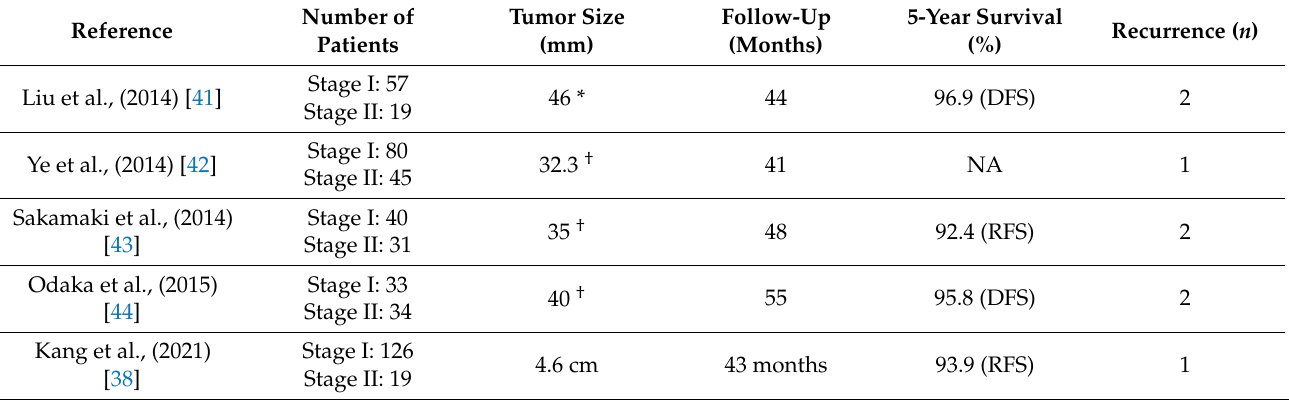
Table 1. Stage I and II Thymoma Resection Survival and